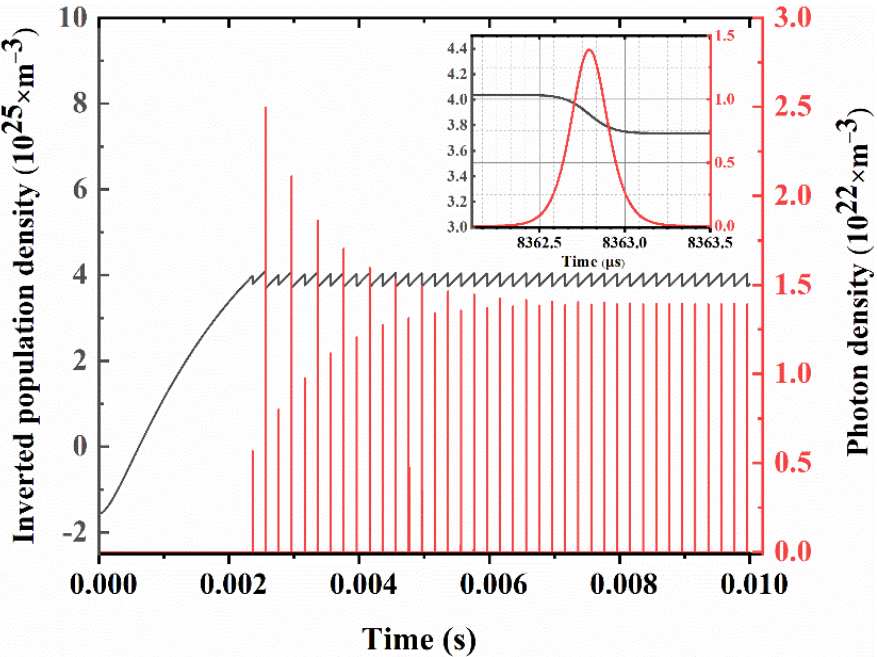
Figure 8. Population inversion density and photon density change in 0.01 s at the repetition frequency of 5 kHz. Inset: expanded picture of single Q-switched